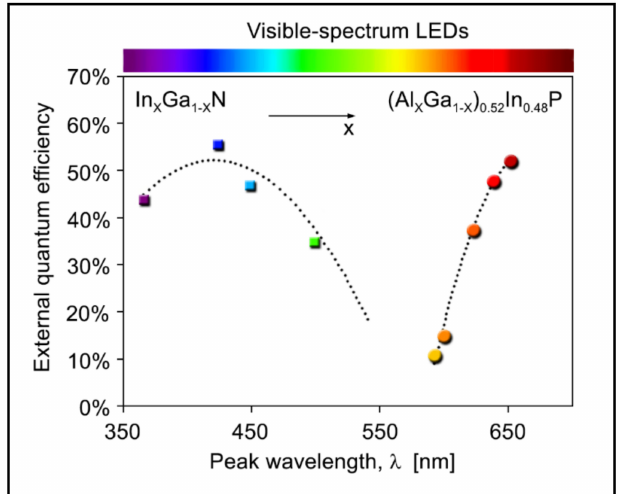
Figure 2. Typical external quantum efficiency and relative emission spectrum vs. molar fractions for indium gallium nitride (InGaN) and aluminum indium gallium phosphide (AlInGaP) light-emitting diode arrays (LEDs). Here, external quantum efficiency is a fraction of the number of photons emitted outside of the semiconductor with respect to those generated overall within